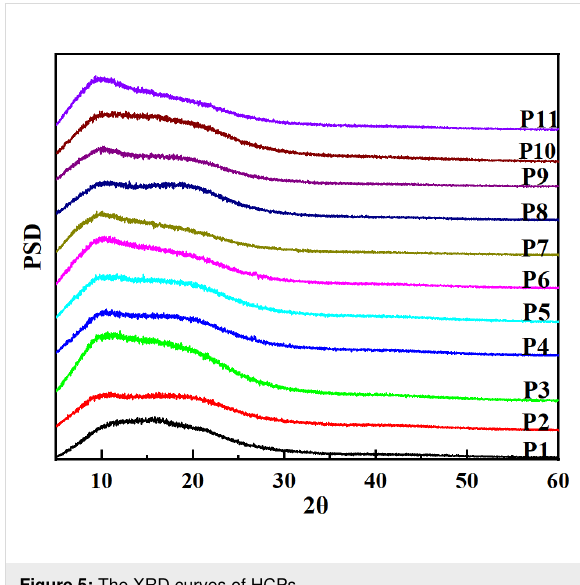
Figure 5: The XRD curves of HCPs.